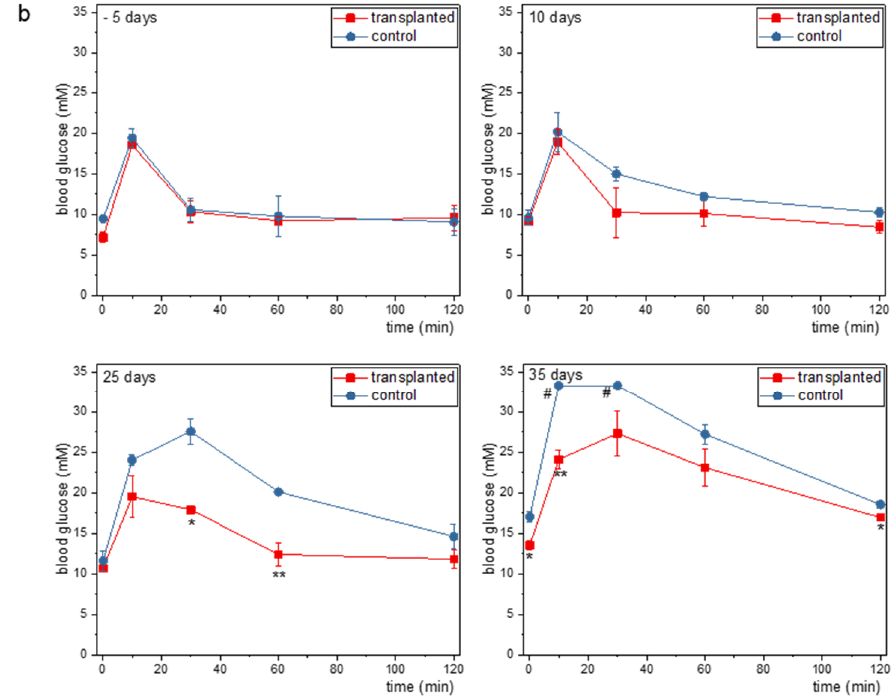
Figure A1. Additional information related to Figure 2. ( a ) Timeline of the first set of experiments. ( b ) Individual traces from the ipGTTs summarized as AUC in Figure 2d. Data are expressed as mean ± SEM. Data points that include saturated glucose measurements that were set to 33.3 mM are labeled with #. * p < 0.05; ** p < 0.01; n = 3.